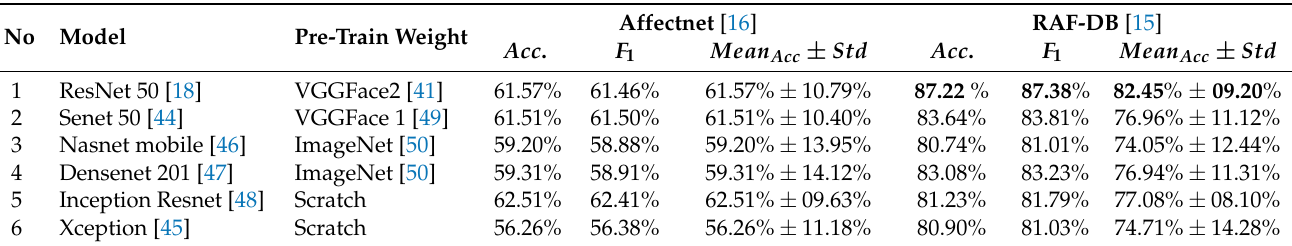
Table 2. Performance of face feature extraction models on the AffectNet and RAF-DB validation sets.